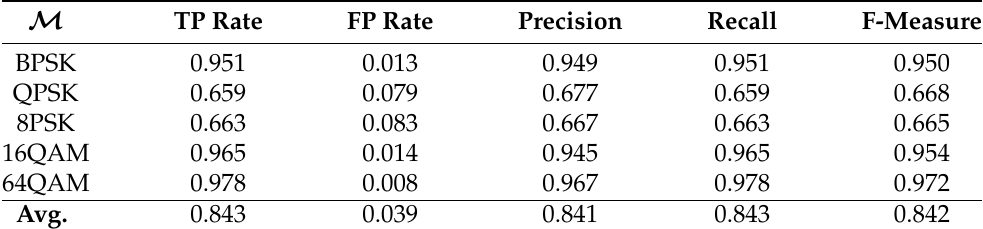
Table 4. Detailed accuracy by modulation type for Adaboost using J48 as a base MLT with L = 3,